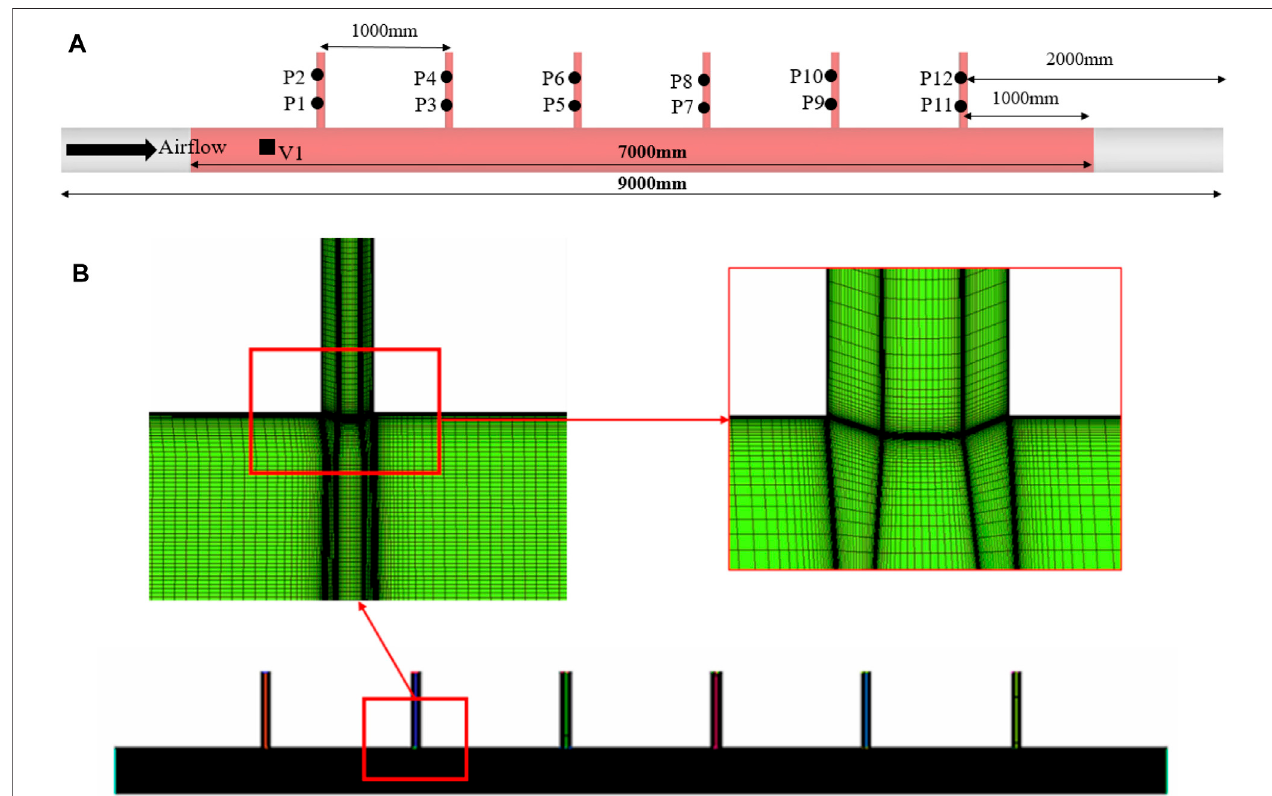
FIGURE 9 | Computational domain and the middle plane of the grid: (A) Computational domain; (B) middle plane of the grid.